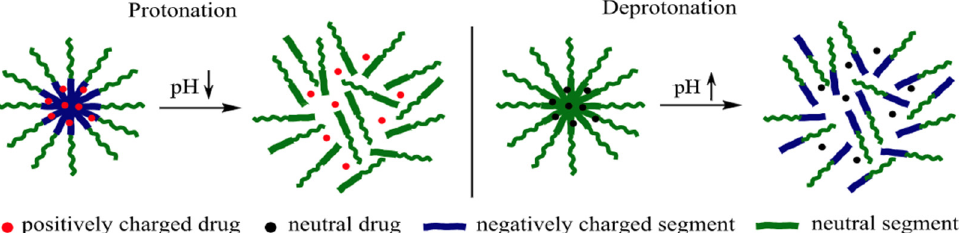
Figure 2. A schematic illustration of drug release from a polymer micelle. Protonation ( left ) or deprotonation ( right ) destroys the polymer micelle [43]. Reprinted from Saudi Pharmaceutical Journal, 28, M. Alsehli, Polymeric Nanocarriers as Stimuli-Responsive Systems for Targeted Tumor (Cancer) Therapy: Recent Advances in Drug Delivery, 255–265, Copyright (2020), with permission from Elsevier.